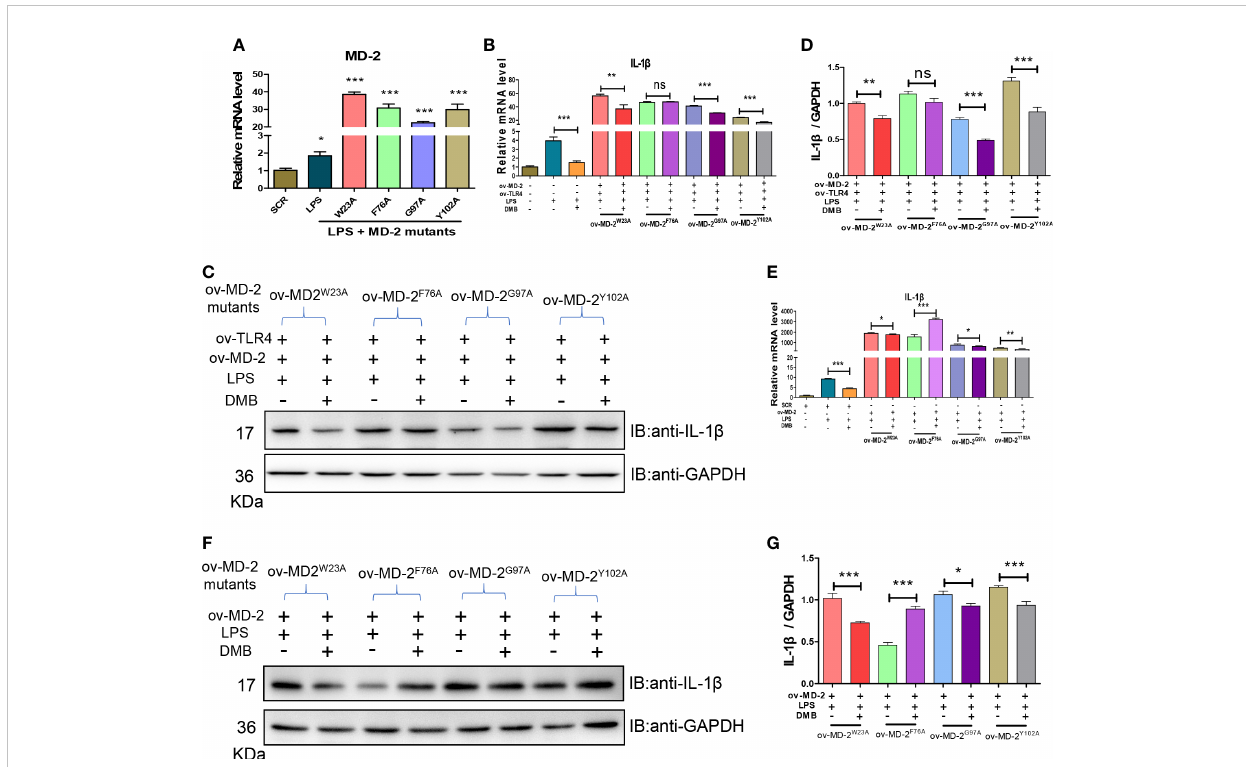
FIGURE 6 DMB interacted with phenylalanine at position 76 of the MD-2 protein. (A) The mRNA levels of MD-2 after overexpression of MD-2 mutants. (B) The mRNA levels of IL-1 b after overexpression of MD-2 mutants and TLR4. (C) The protein expression of IL-1 b after overexpression of MD-2 mutants and TLR4. (D) The grayscale analysis of IL-1 b after overexpression of MD-2 mutants and TLR4. (E) The mRNA levels of IL-1 b after overexpression of MD-2 mutations. (F) The protein expressions of IL-1 b after overexpression of MD-2 mutations. (G) The grayscale analysis of IL-1 b after overexpression of MD-2 mutations. Statistical analysis was performed using one-way ANOVA. n = 3. * p < 0.05, ** p < 0.01, *** p < 0.001, ns, non- signi fi cantly (*: the DMB group versus the LPS group).